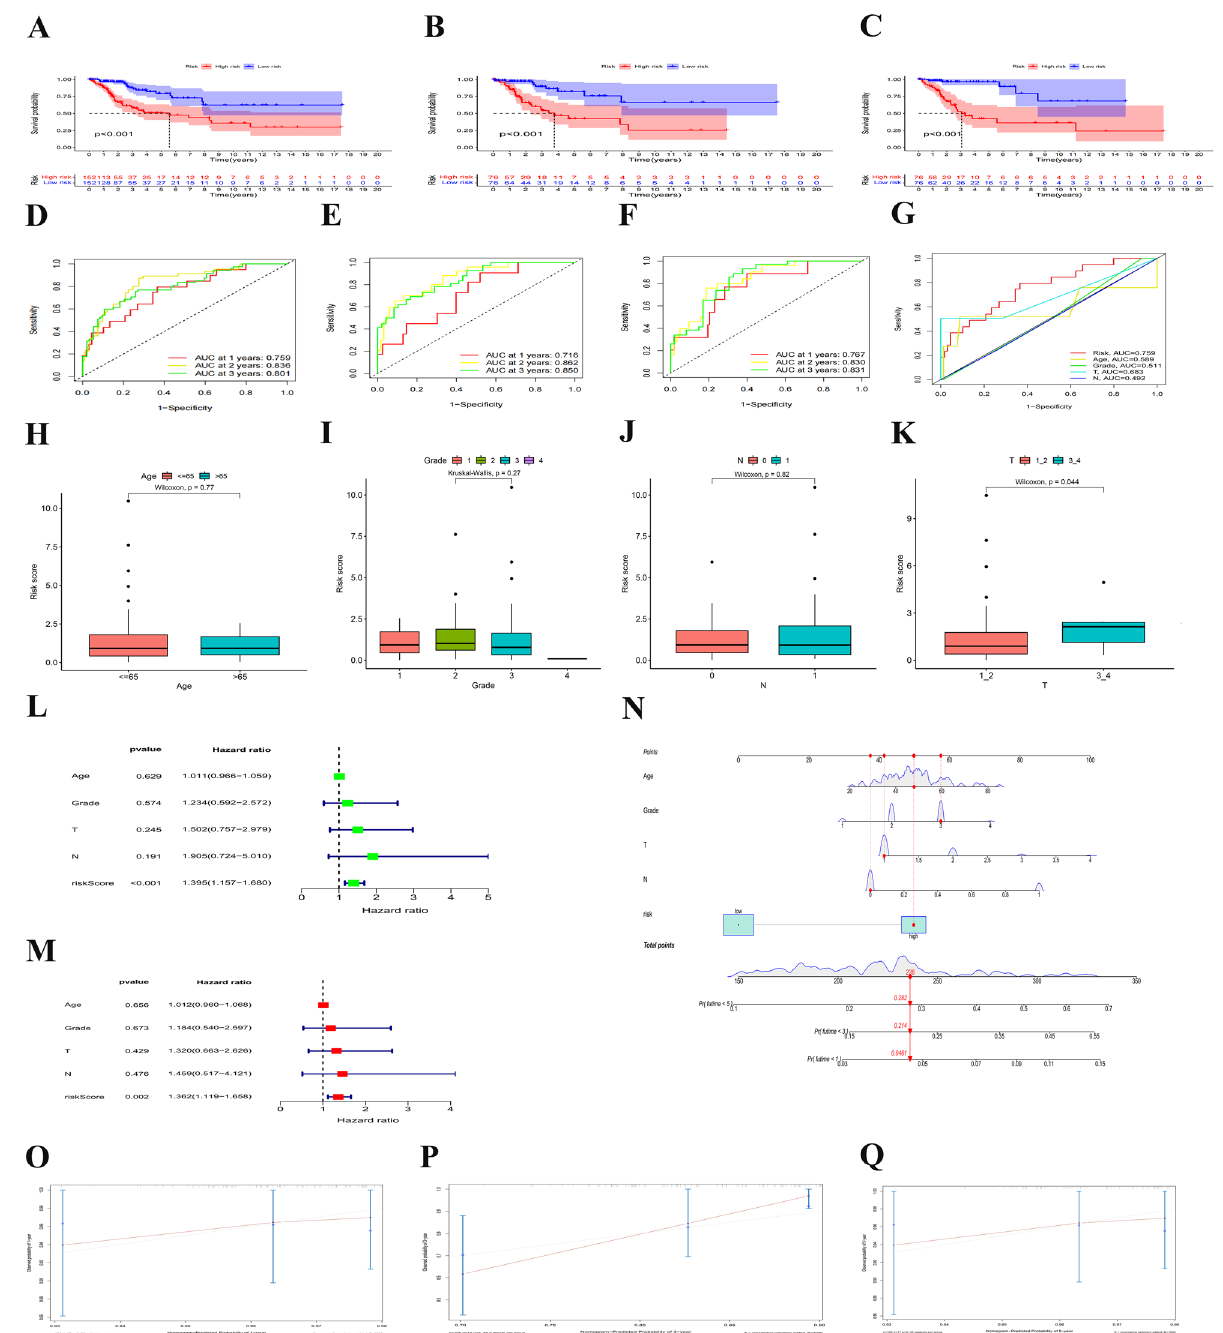
Figure 3. Associations between risk signature and clinicopathological factors. ( A – C ) Survival curve of CESC patients. ( D – F ) TimeROC curves with two sets of validation datasetsand and ( G ) Clinical ROC curves to forecast overall survival of patients. Visualization of risk scores in clinical data ( H – K ). Univariate ( L ) and multivariate Cox ( M ) regression of clinicopathological features in TCGE-CESC cohort. ( N ) Nomogram constructed to predit OS rates at 1, 3 and 5 years. ( P – Q ) The nomagram calibration curves were applied for investigation the deviation in nomagram-predicated and actual 1-, 3-, and 5-years survival